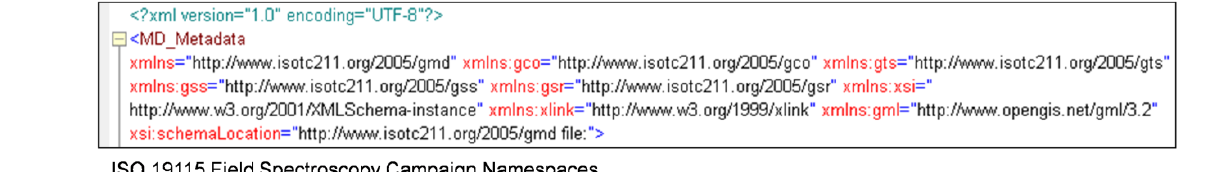
Figure 4. ISO 19115 profile for field spectroscopy